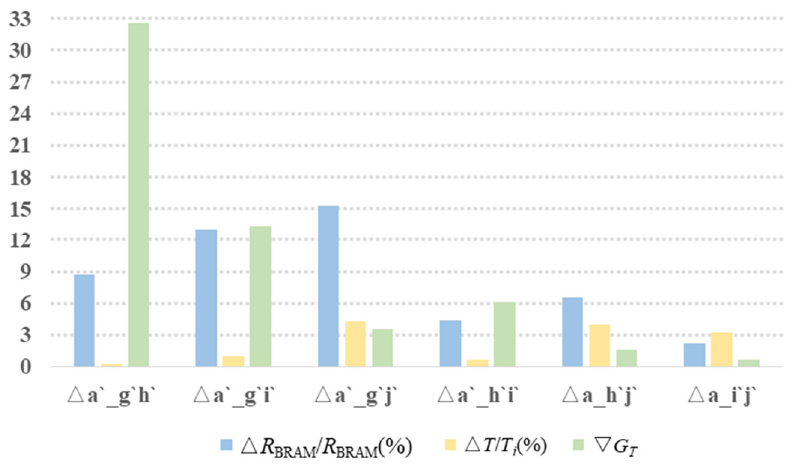
∇ G of matrix transposition schemes under the condition of a‘ Figure 11.  G of matrix transposition schemes under the condition of a`. Figure 11.